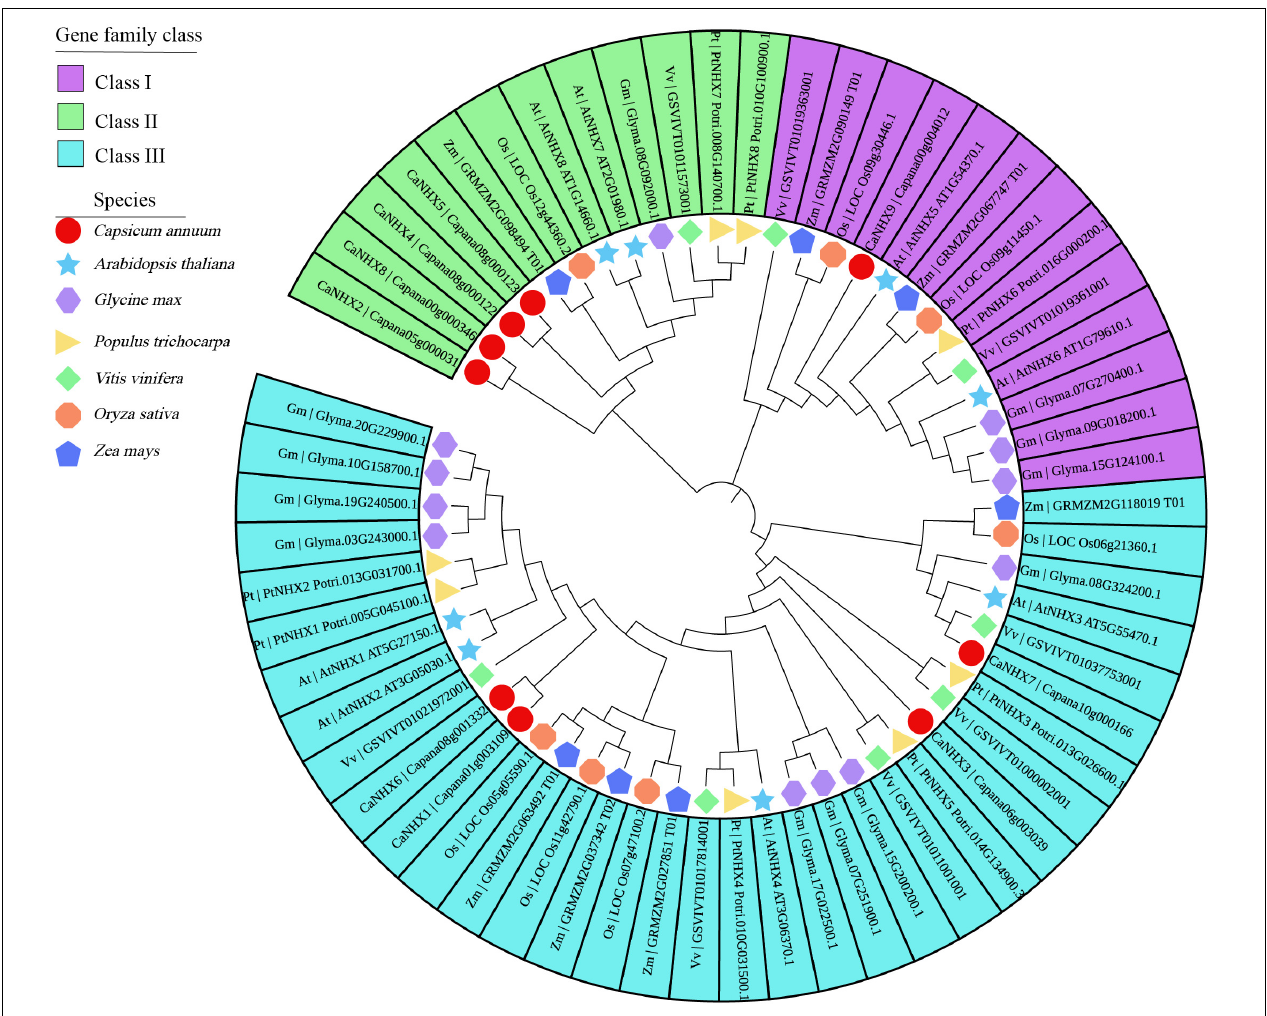
FIGURE 1 | Phylogenetic analysis of CaNHX genes in C. annuum. Square: C. annuum; Star: A. thaliana; Horizontal hexagon: G. max; Right triangle : P. trichocarpa; Rhombus : V. vinifera; Octagon : O. sativa; Up pointing pentagram : Z. mays.